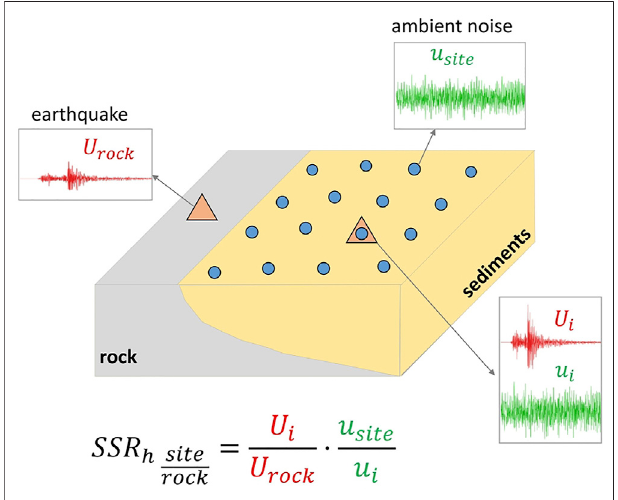
FIGURE 1 | Schematic visualization of the SSRh method. Capital U